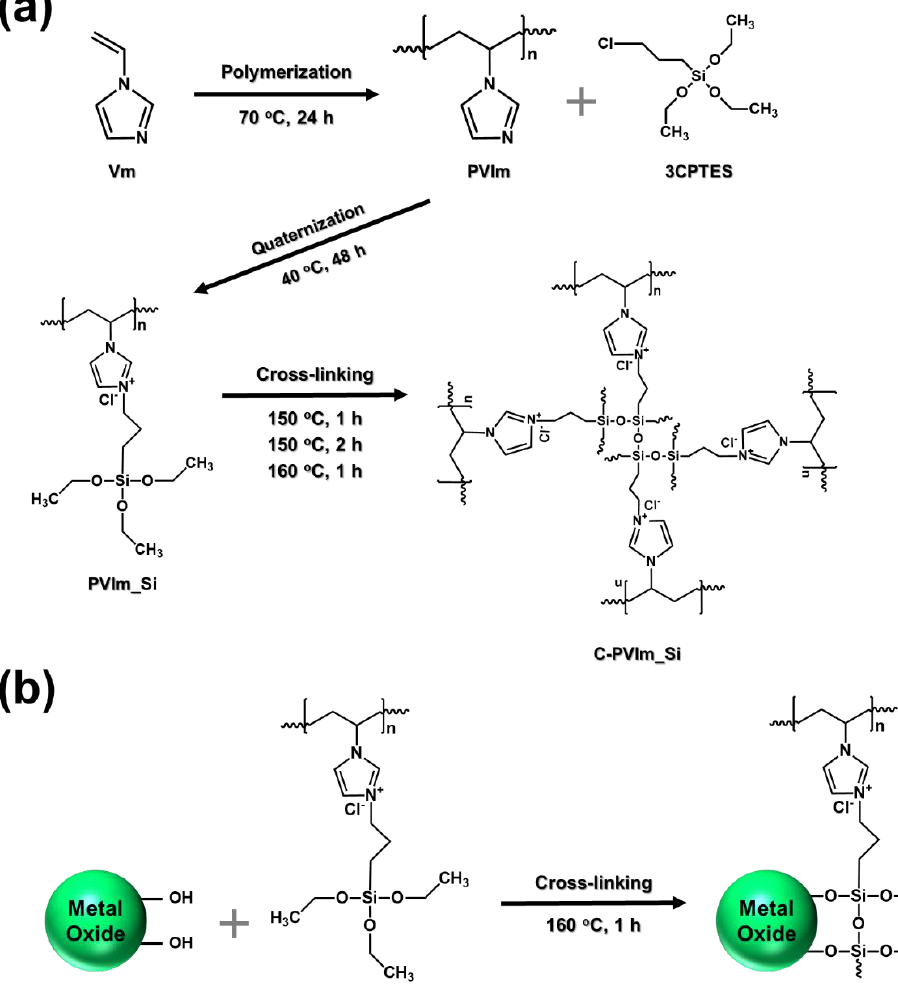
Figure 1. ( a ) Synthesis of C-PVIm_Si; ( b ) metal oxide surface